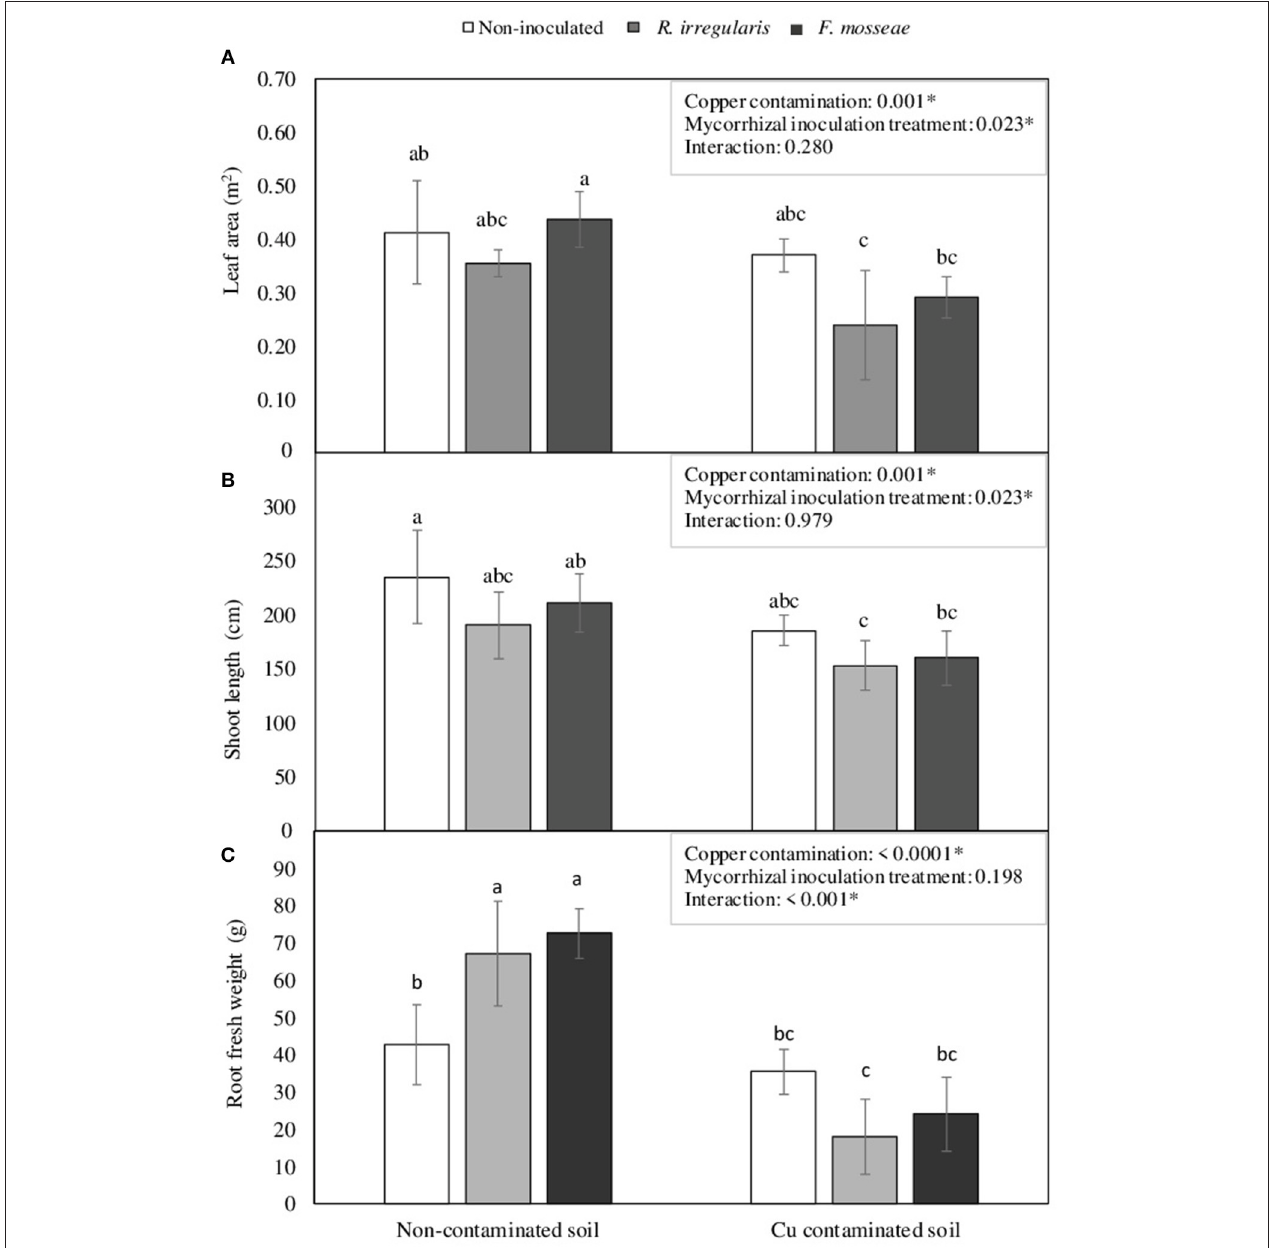
FIGURE 3 | (A) Leaf area, (B) shoot length, and (C) root fresh weight in Touriga Nacional grapevine variety plants grafted onto 1103P rootstock inoculated or not with R. irregulare or F. mosseae . Each bar represents the average value of five plants ± standard error. Different letters indicate significant differences according to Tukey b post-hoc test. The box inside the graphics indicate the significance values of the two-way factorial ANOVA with interaction where Copper contamination and Mycorrhizal inoculation treatment were considered as main